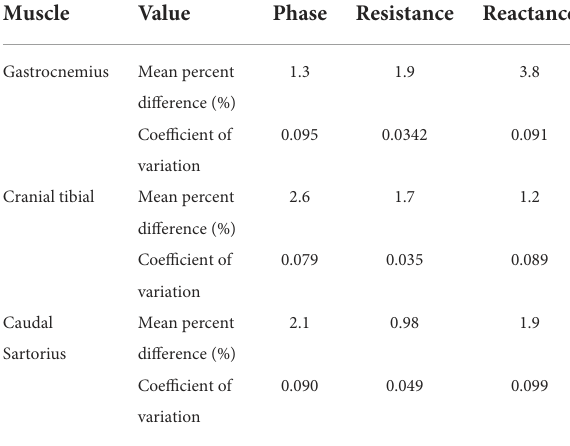
TABLE 4 Single evaluator, within-session EIM repeatability